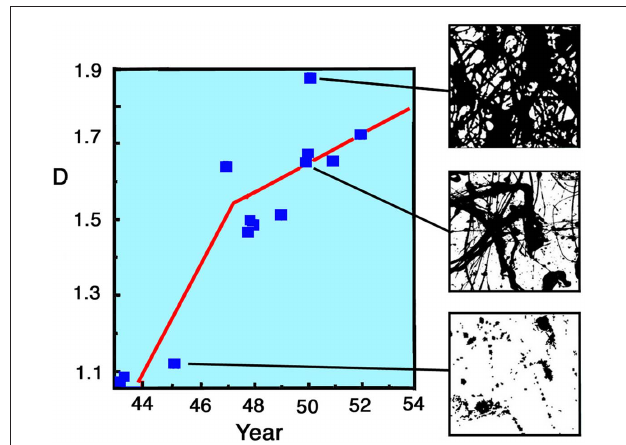
FiGurE 3 | The fractal dimension D of Pollock paintings plotted against the year in which they were painted (1943–1953). See text for details. The right hand images show computer constructions of three of